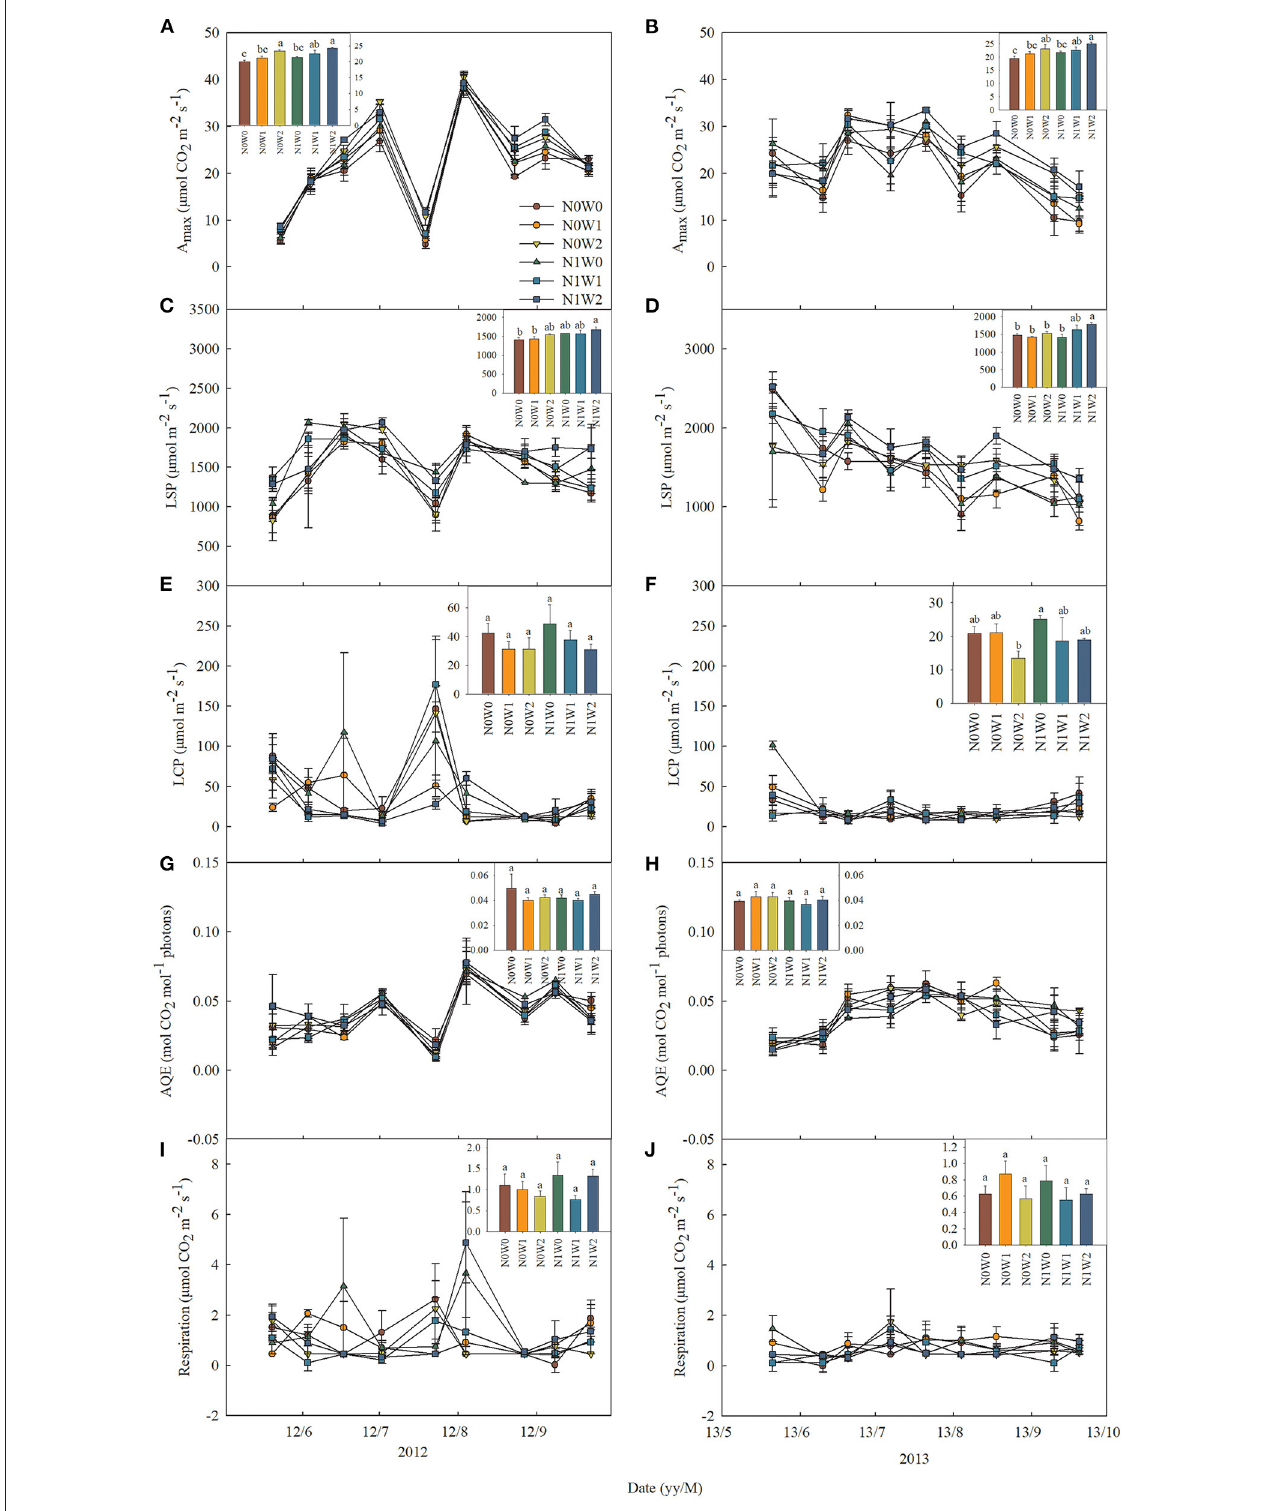
FIGURE 3 | Seasonal dynamics of leaf photosynthetic characteristics of Stipa grandis in 2012 (left panels) and 2013 (right panels) including (A,B) the maximum photosynthetic rate (A max ), (C,D) light saturation point (LSP), (E,F) light compensation point (LCP), (G,H) maximum apparent quantum yield (AQE), and (I,J) respiration. Inset figures show the average values across seasons with different letters indicating significant differences ( P < 0.05) among the six treatments. Values represent mean ± SE ( n =